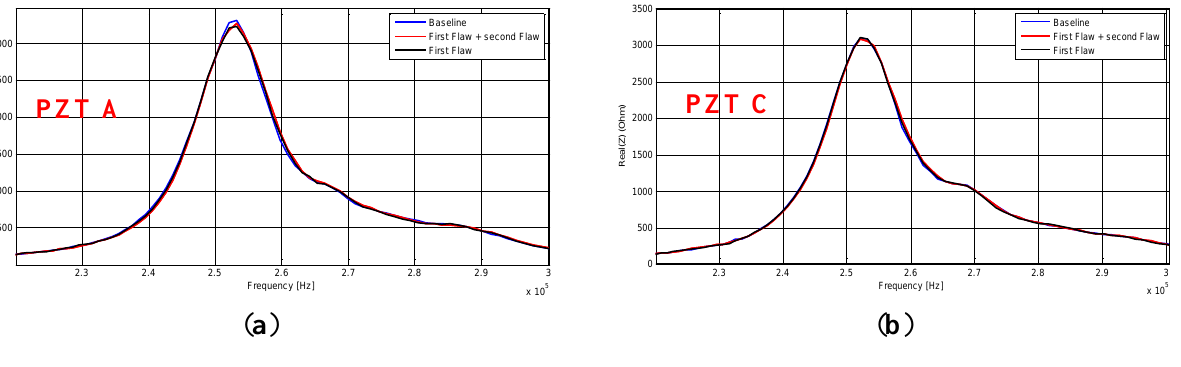
Figure 20. Real part impedance spectrum [220 kHz; 300 kHz] for the healthy signature, the response with one flaw and the response with two damages ( a ) superposed responses for PZT A. ( b ) Superposed responses for PZT C. ( c ) Superposed responses for PZT B.